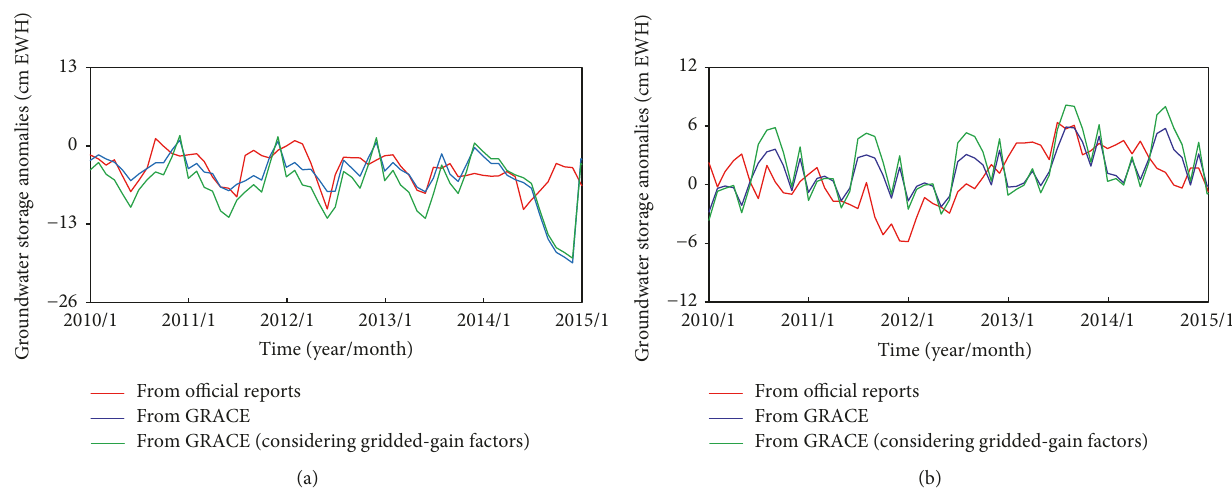
Figure 5: Comparison of the monthly measured and derived GWS variations in (a) the Huang-Huai-Hai Plain and (b) the Song-Liao Plain.